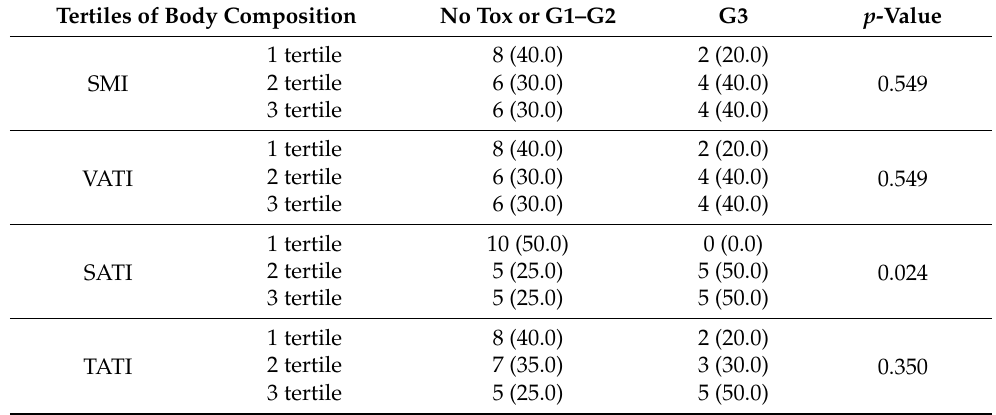
Table 6. Toxicities by